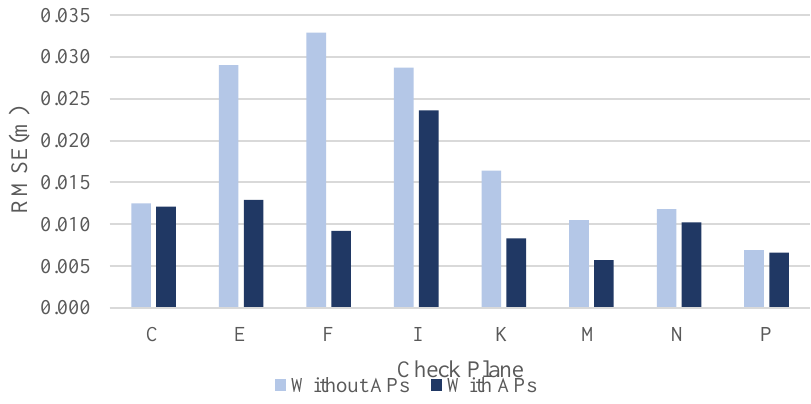
Check Plane Without APs Figure 13. The bar chart of RMSE for check planes. Figure 13. The bar chart of RMSE for check planes.